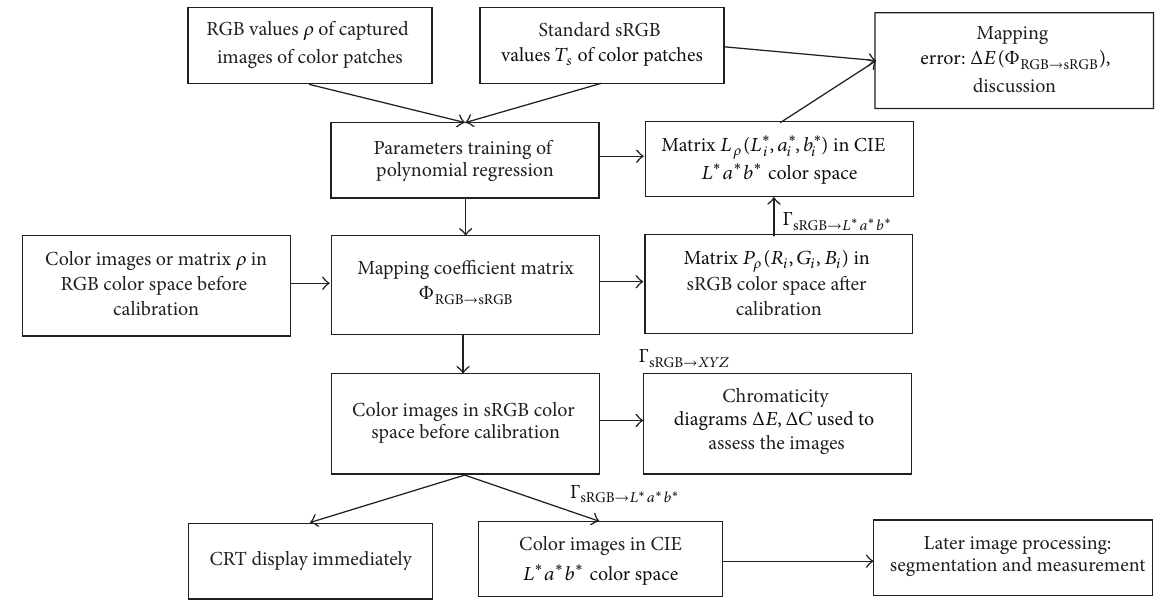
Figure 3: Schematic diagram of the calibration algorithm in sRGB color space.